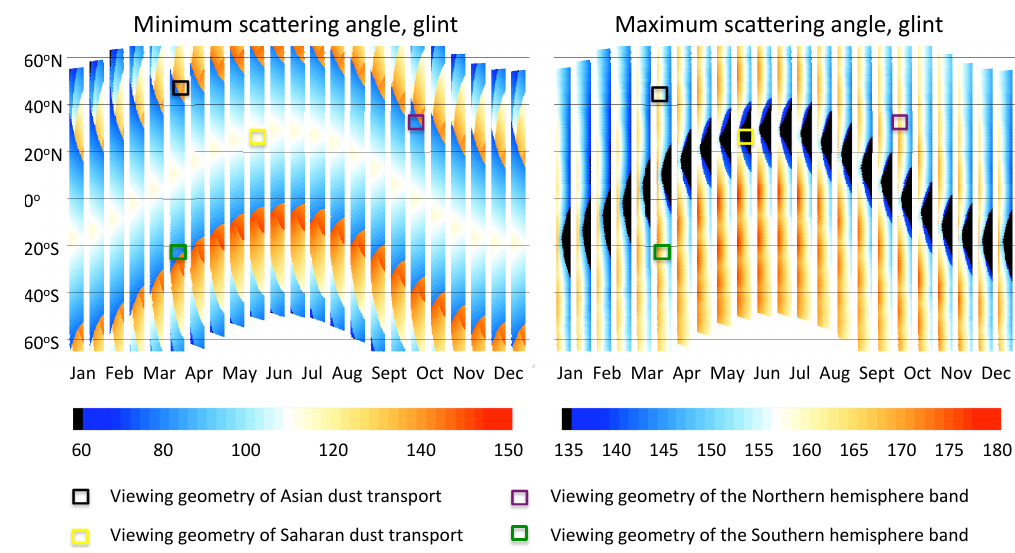
Fig. 10. (a) Minimum scattering angle ( 2 min ) used in the MISR Dark Water retrieval algorithm excluding cameras within 40 ◦ of the specular direction that could potentially be affected by sunglint, presented in the same manner as Fig. 6. (b) Maximum scattering angle ( 2 max ) used in the MISR Dark Water aerosol retrieval algorithm. Colored boxes indicate latitudes and times for viewing geometries of